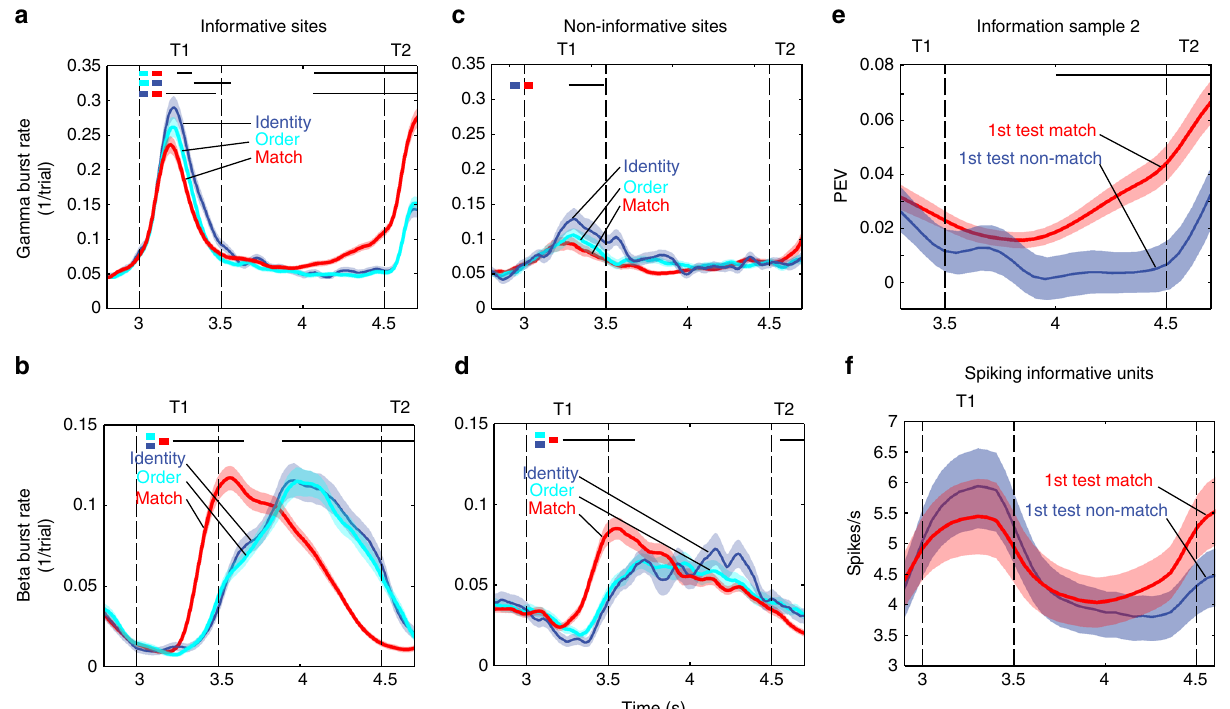
Fig. 6 Burst activity around the fi rst test. Plots show burst rates during presentation of the fi rst test object (T1) and the following delay for correct trials. a Gamma burst rate for matching (red) and non-matching sequences (object identity violation, dark blue; order violation, turquoise) in sites with at least one unit carrying signi fi cant information about the identity of sample 1 or 2 ( n = 130). Black horizontal lines denote intervals with signi fi cant differences between burst rates in conditions indicated by the corresponding colored squares ( p < 0.05; cluster-based statistics with permutation test). b Same as a but for beta burst rate. c Same as a but for sites with no informative units ( n = 58). d Same as b but for sites with no informative units. e PEV information about the identity of sample 2 (tested after the delay at T2) for units with signi fi cant PEV/information during delay (using neurons that also had LFPs recorded; n = 146) in two groups of trials: with matching (red) vs non-matching (blue) pair of objects, S1 and T1 (at fi rst test). Black horizontal line marks an interval where the PEV means in the two groups of trials are signi fi cantly different ( p = 0.001; one-sided cluster-based permutation test). f Average fi ring rates at informative sites ( n = 189) for fi rst test matching (red) and non-matching (blue) conditions (analogously to e )). Error bars/shading correspond to